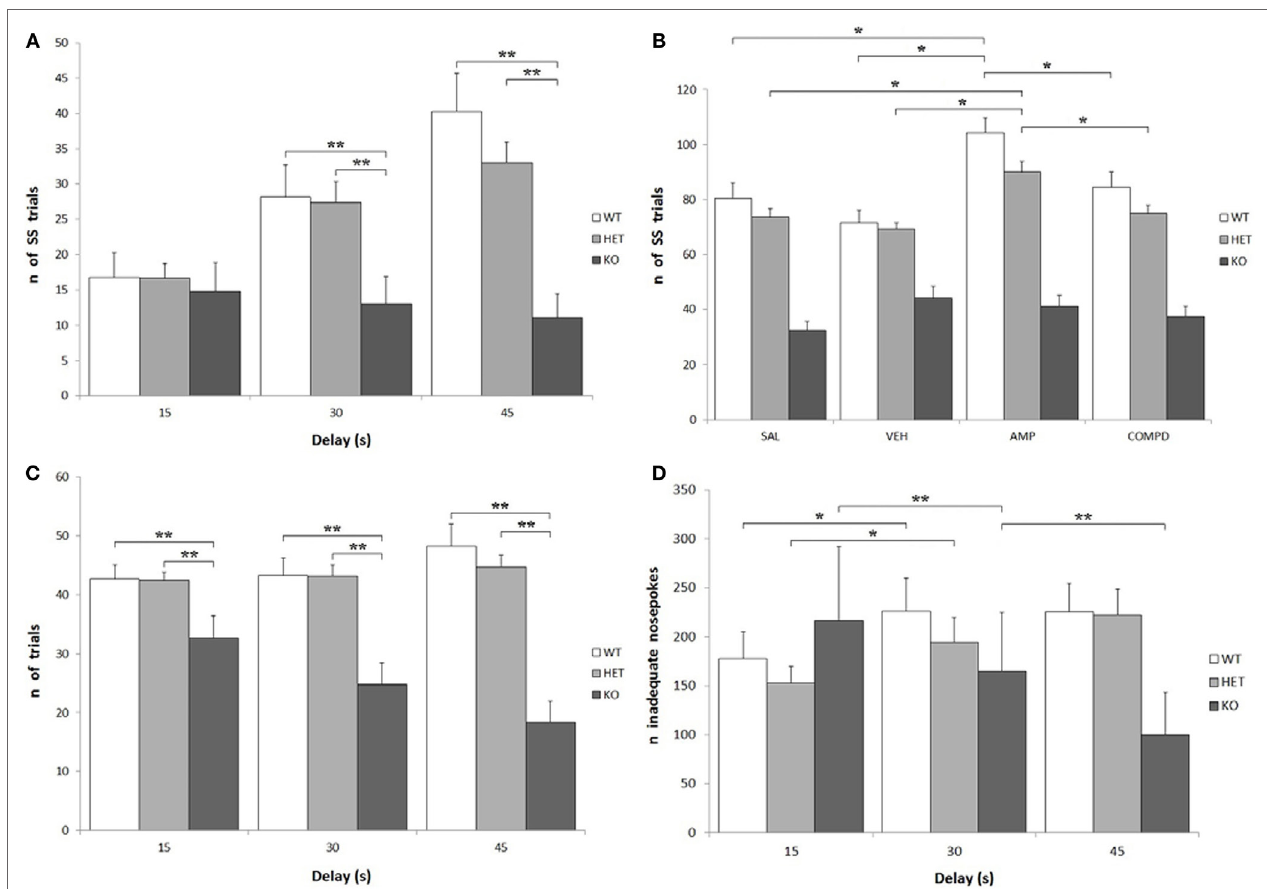
FigUre 4 | Other parameters from the Intolerance-to-Delay Task. (a) Total small-and-soon (SS) trials at increasing delays. While there is a clear increase of the number of SS trials at higher delays in wild-type (WT) and dopamine transporter (DAT)–heterozygous (HET) rats, knockout (KO) rats did not show such an increase. ** P < 0.0001. (B) The effect of the different drugs on the total SS trials. The administration of amphetamine (AMPH) on WT and DAT–HET rats has a significant effect to increase the total SS trials, if compared to saline, vehicle, and RO-5203648. * P < 0.05. (c) Total [SS + large-and-late (LL)] trials performed at all the three delays: total trials of KO rats were always significantly lower than those of WT and DAT–HET rats. ** P < 0.0001. (D) The total inadequate nose-pokes, performed in both nose-poking holes during the timeout (i.e., when without consequences). For WT and DAT–HET rats, the total inadequate nose-pokes significantly increase at higher delays; conversely, for KO rats, inadequate nose-pokes significantly decrease at higher delays. * P < 0.05, ** P <